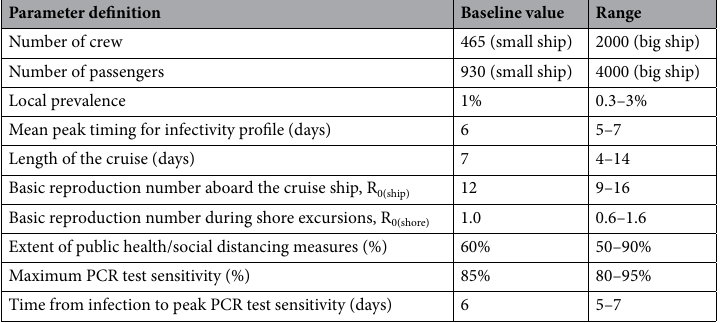
Table 1. Parameter definitions, baseline values, and ranges considered in global sensitivity analyses.